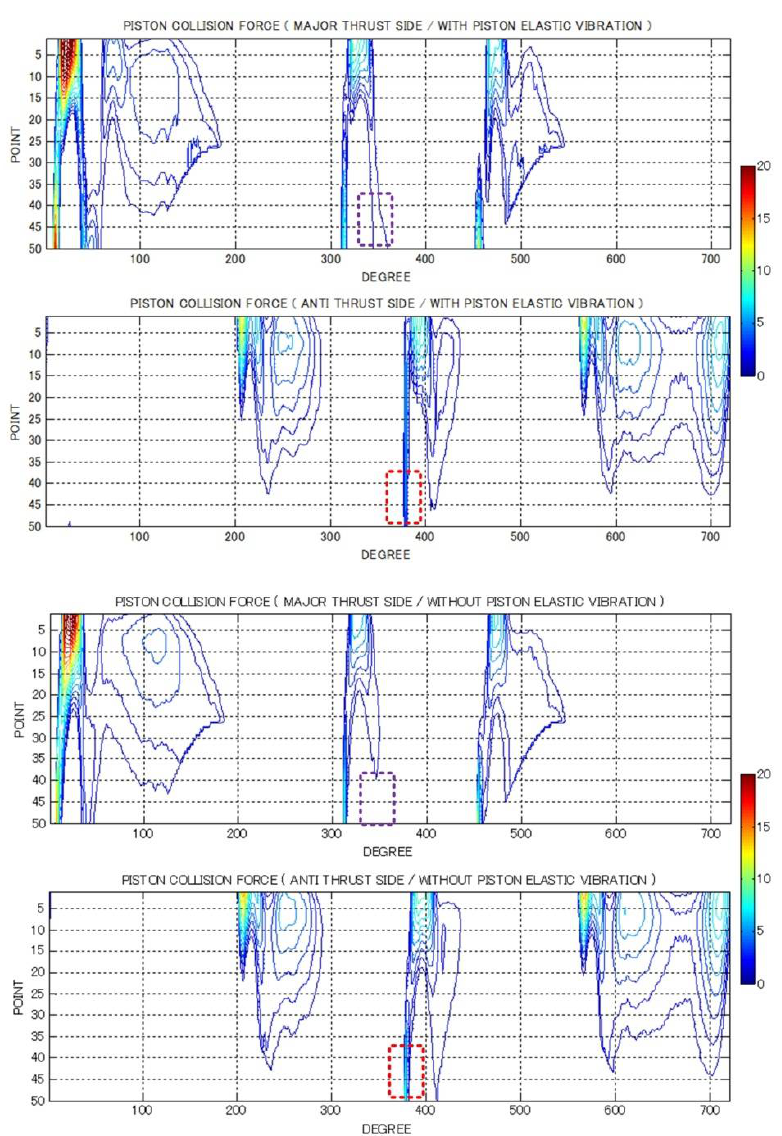
Figure 4. One-third octave band spectrum of the summation of piston collision forces with/without dynamic features of the piston.